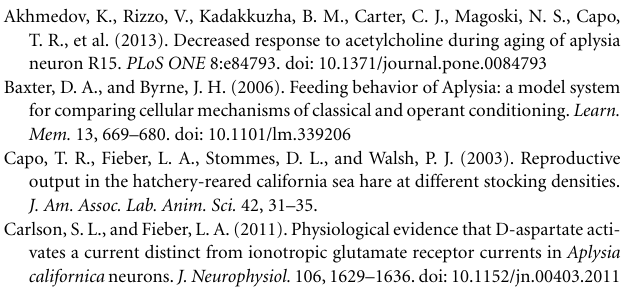
Table 2 | Stages of aging in Aplysia based on age and behavior. Stage of